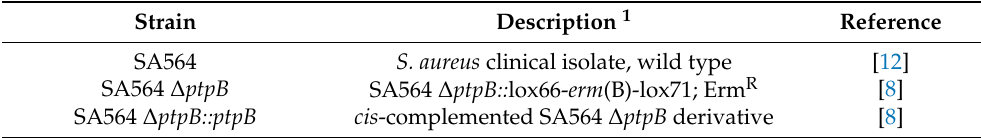
Table 1. Strains used in this